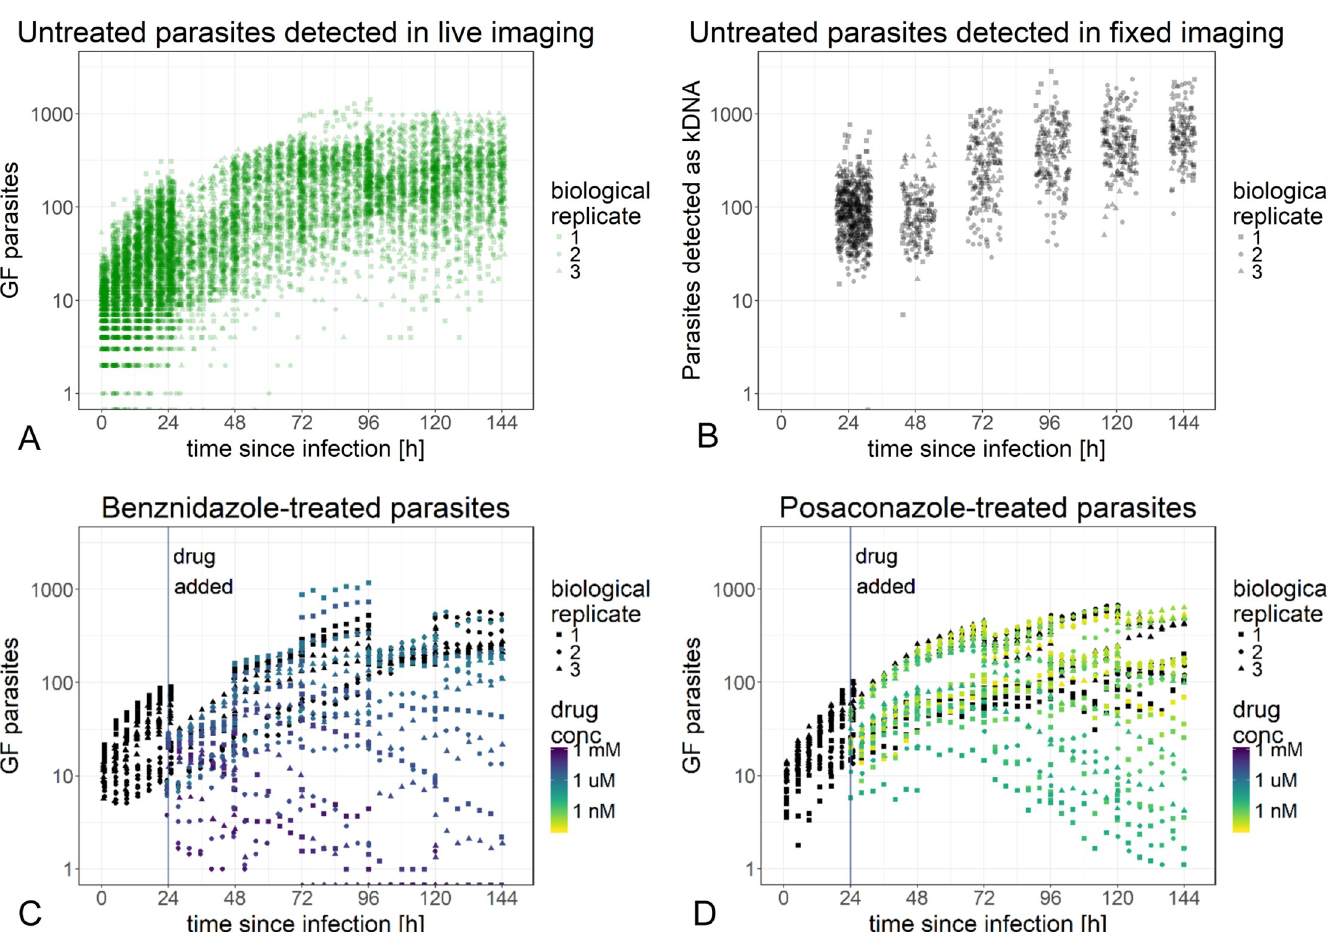
Fig 3. Parasite numbers over time after infection and drug exposure. The assay design was used to monitor the development of parasite numbers for posaconazole and benznidazole treated parasites. Number of untreated parasites per image over time after infection are depicted from live (A) and fixed (B) imaging with detection as green fluorescent parasites or as kinetoplasts, respectively. Mean number of treated parasites per image per well is depicted for benznidazole (C) and posaconazole (C) in live imaging detected as green fluorescent parasites. Untreated controls are depicted in black (C, D).